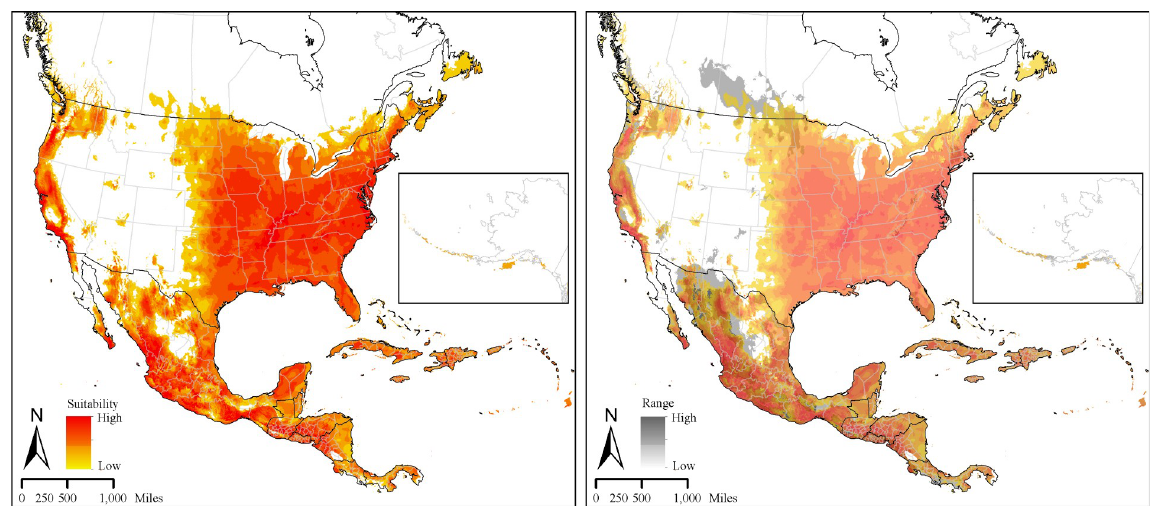
Fig 2. A. Prediction of bio-climatically suitable areas for Dermacentor variabilis ticks in North America. B. Uncertainty (range = maximum– minimum suitability value) associated with the prediction of suitable areas for Dermacentor variabilis distribution in North America.